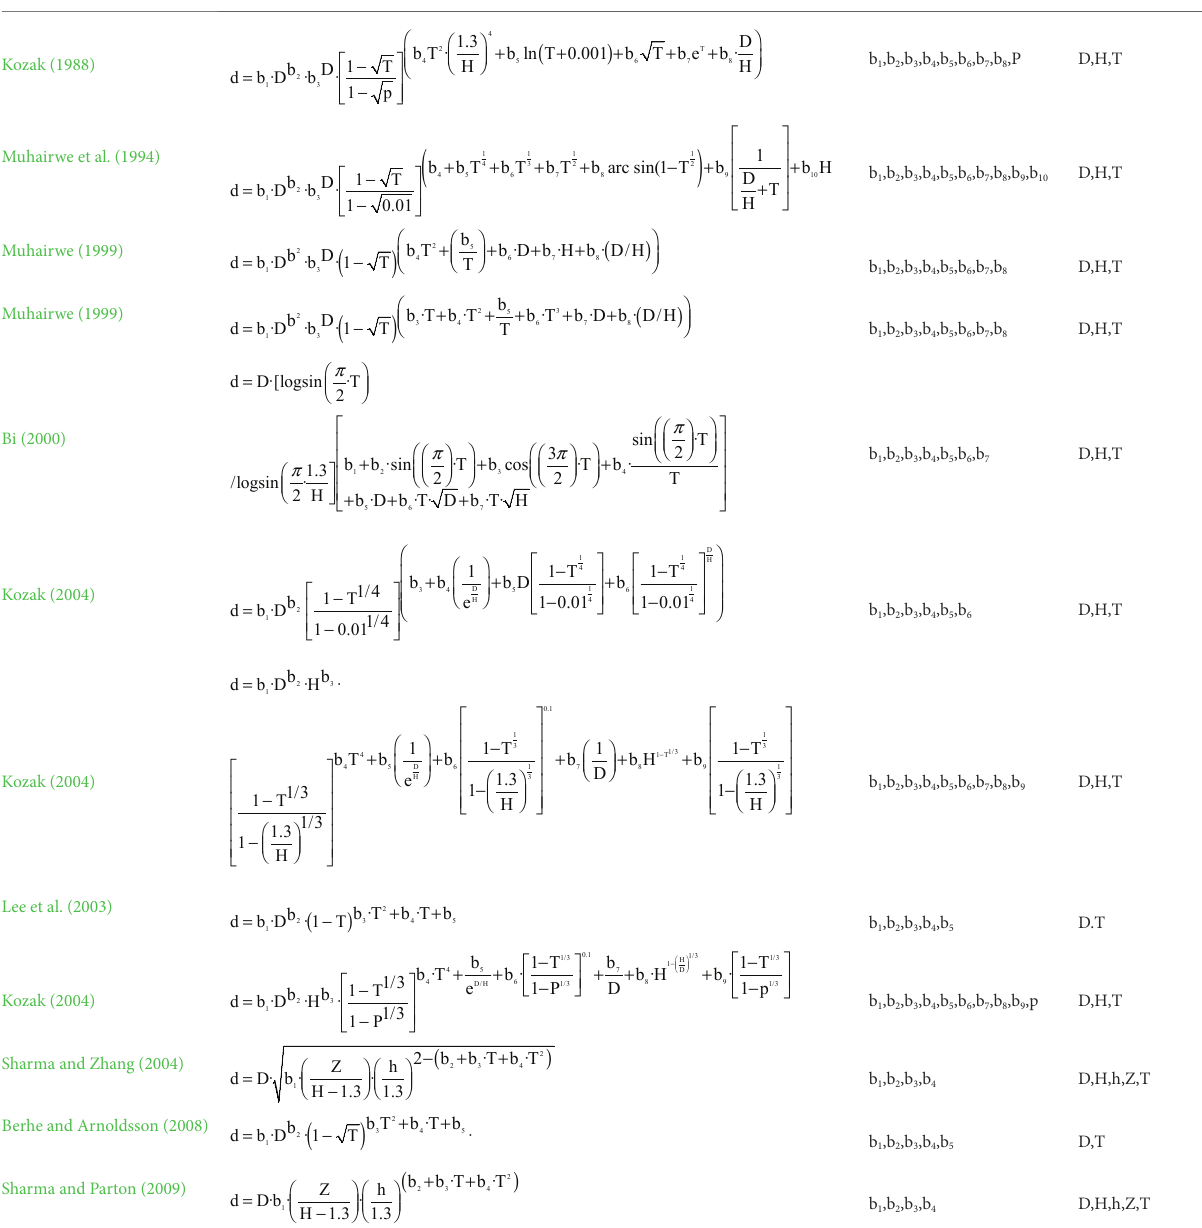
TABLE 2 The 12 stem taper equations selected as candidate models. Origin model form Parameters